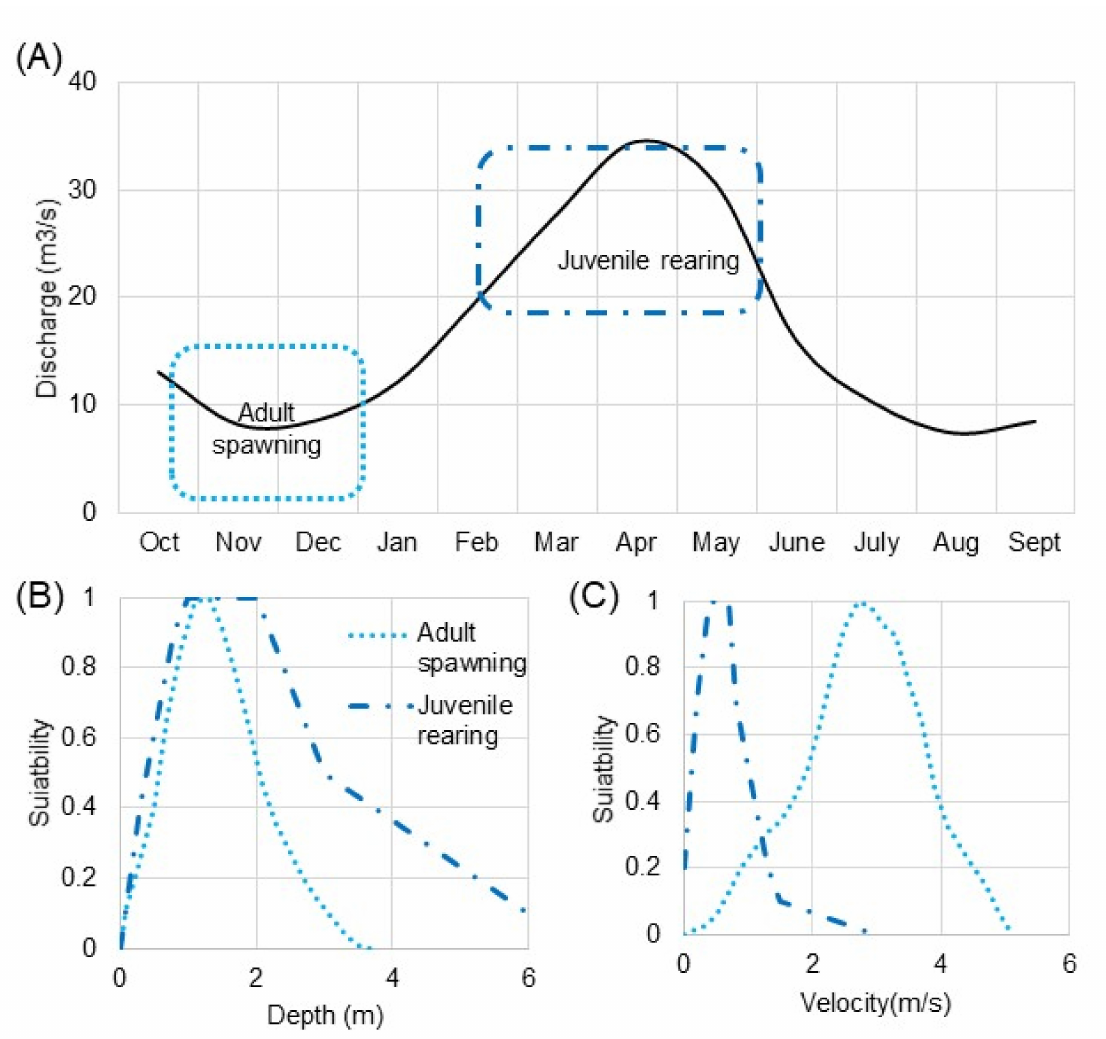
Figure 7. Examples of ecohydrology and ecohydraulics. Ecohydrology ( A ) entails relating species and/or life stages with seasonal hydrology. In this case monthly average flow is shown for the Merced River, CA USA near the town of Snelling from 1994 to 2017 along with primary adult spawning and juvenile rearing periods for fall-run Chinook Salmon. Note that other life stages are important to consider (see Figure 1) but are omitted for clarity. Ecohydraulics utilizes habitat suitability curves to determine the range and optimal depths ( B ) and velocities ( C ) needed for a given life stage and are applied to the flows relevant to that life stage. The curves shown here are for fall-run Chinook Salmon spawning [167] and rearing